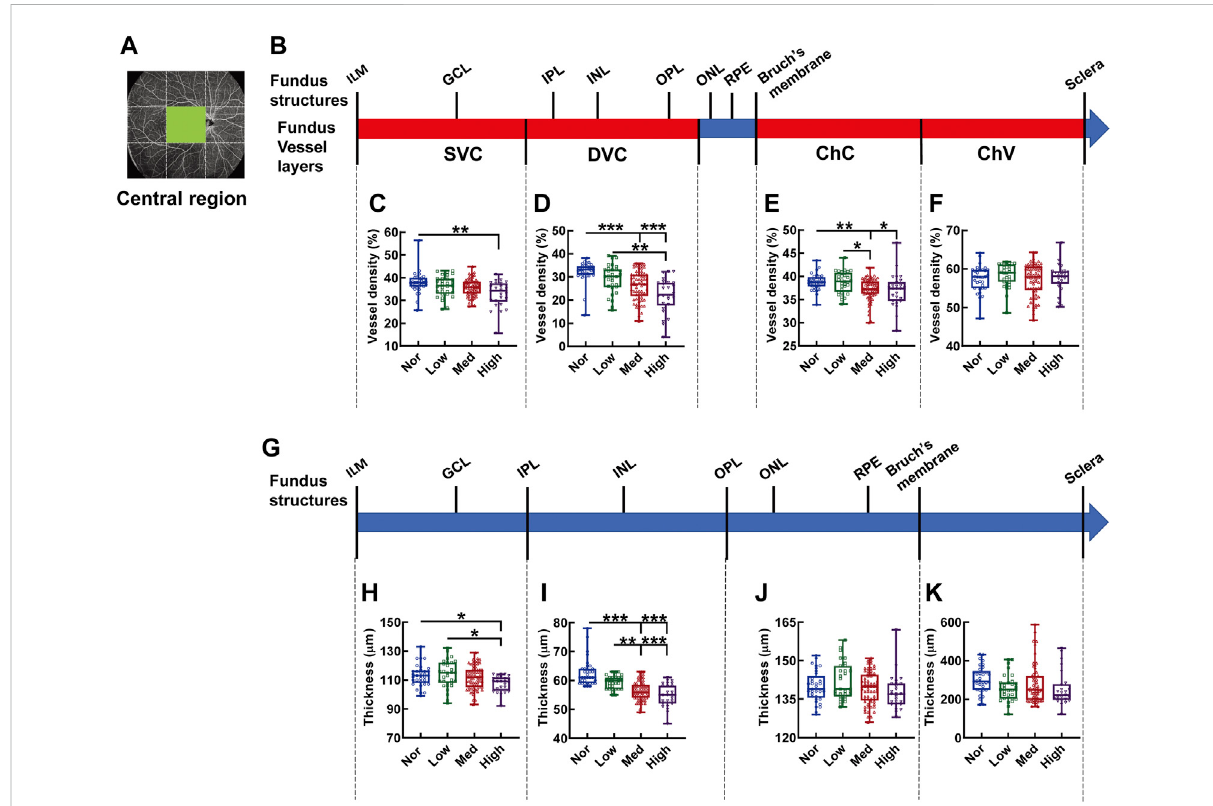
FIGURE 7 Vessellayerdensitiesandstructurethicknessesatthecentralmacularregion ofthefundus. Positionofthecentralmacularregionofthefundus is illustrated in (A) . Schematic illustration of vessel layers in the fundus is shown in (B) . Vessel densities of super fi cial vascular complex (C) , deep vascular complex (D) , choriocapillary (E) , and choroidal vessel (F) layers are quanti fi ed and compared. Schematic illustration of segments in the fundus is shown in (G) . Thicknesses of the segments from IML to IPL (H) , from IPL to OPL (I) , from OPL to Bruch ’ s membrane (J) , and from Bruch ’ smembraneto thesclera (K) are quanti fi edand compared. * p < 0.05, ** p < 0.01, *** p < 0.001. SVC, super fi cialvascularcomplex;DVC, deep vascular complex; ChC, choriocapillary layer; ChV, choroidal vessel layer; NOR, normal group; Low, low-myopia group; Med, medium-myopia group; High, high myopia group; IML, inner limiting membrane; IPL, inner plexiform layer; and OPL, outer plexiform